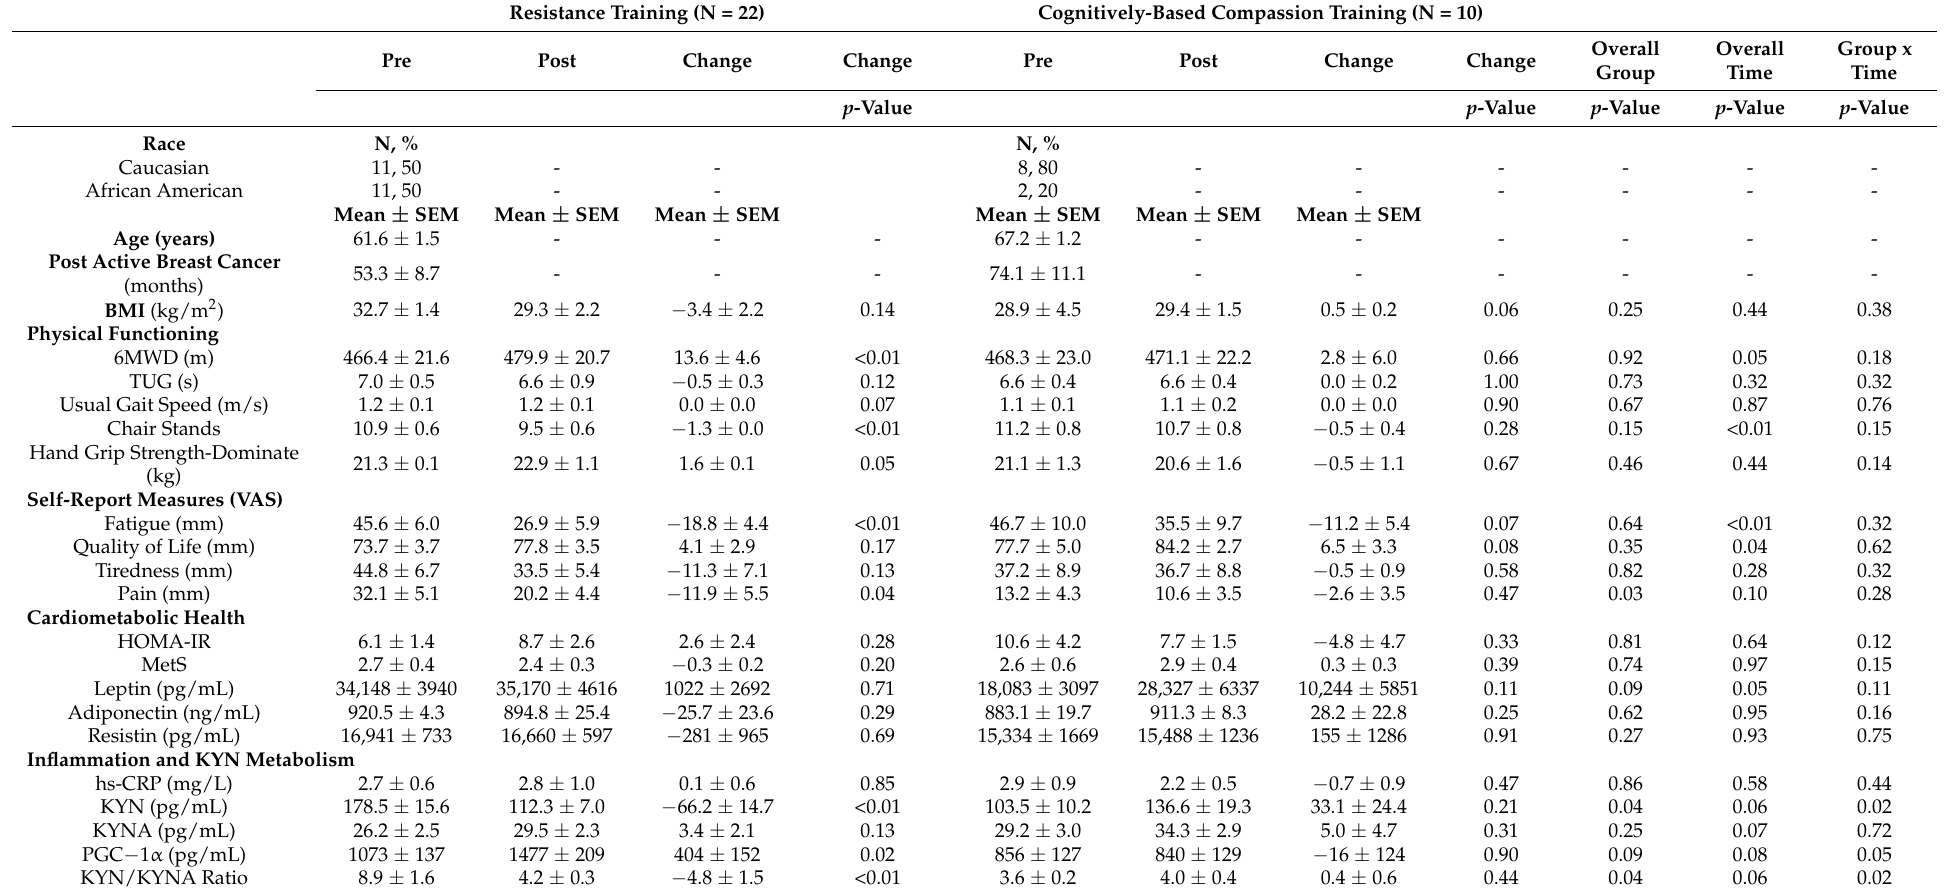
Table 1. Baseline characteristics and effects of RT on physical, psychological and metabolic